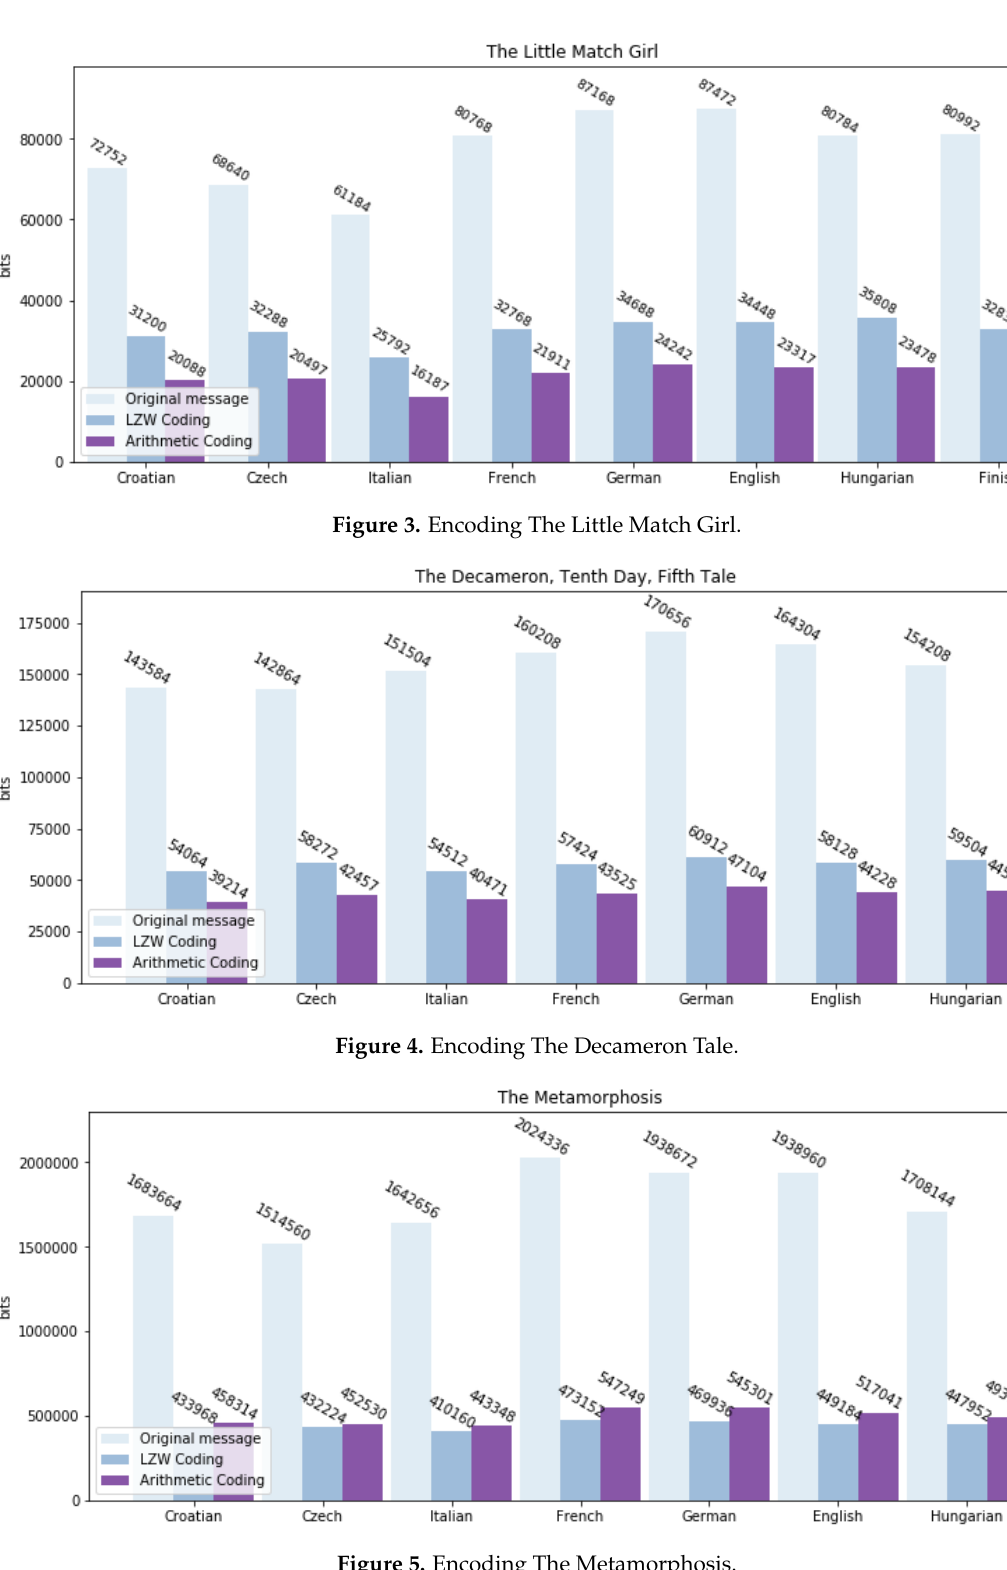
Figure 5. Encoding The